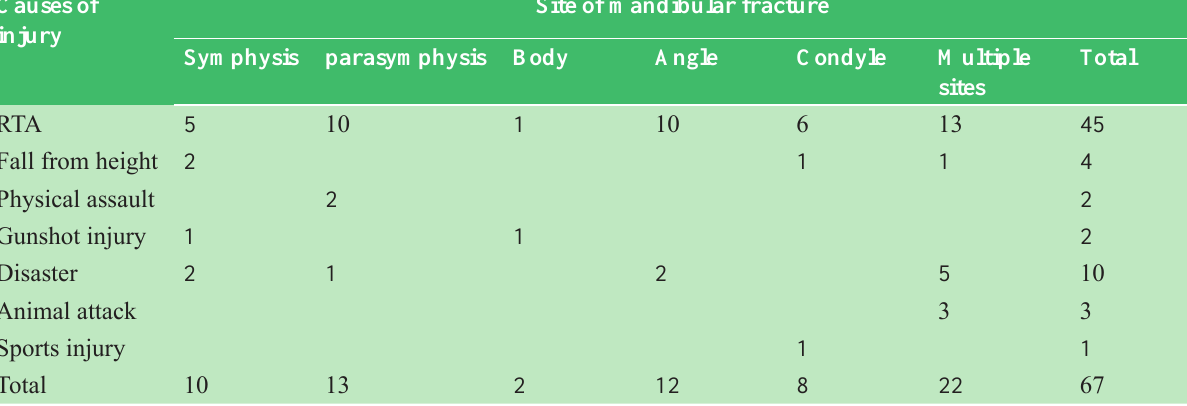
Table2: Site and etiological distribution of mandibular fractures. Causes